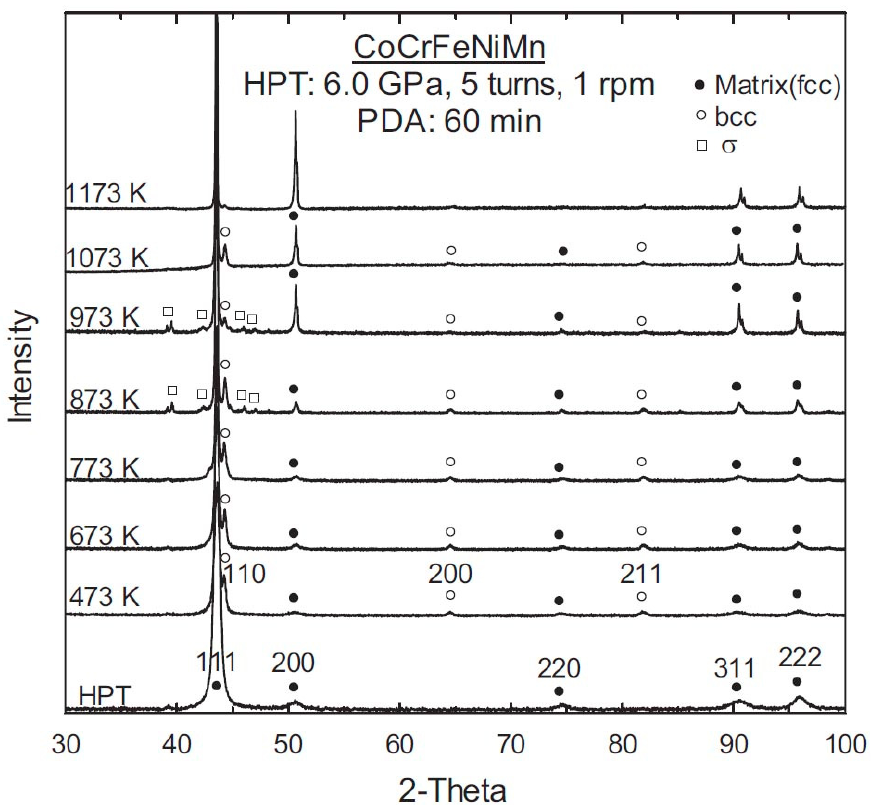
Figure 3. XRD patterns near the edges of the disk after HPT processing followed by post-deformation annealing at 200–900 ◦ C for 60 min. Reprinted with permission from Ref. [20]. Copyright 2016 Elsevier.